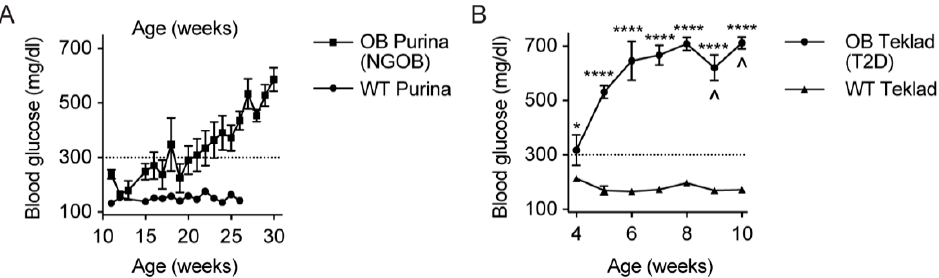
(T2D): ( A ) random-fed blood glucose readings of n = 6–8 Purina diet-fed wild-type (WT) and BTBR Ob mice. Data represent mean ± SEM, although, as not all BG levels for all mice were recorded every week, a statistical analysis was not performed. ( B ) Weekly random-fed blood glucose readings of Teklad-fed WT and BTBR Ob mice: n = 6–8 mice per group. Data represent mean ± SEM and were compared by two-way ANOVA with Holm-Sidak test post hoc. * p < 0.05 and **** p < 0.0001. ˆ indicates that 1–2 BTBR Ob mice were euthanized after human endpoints were